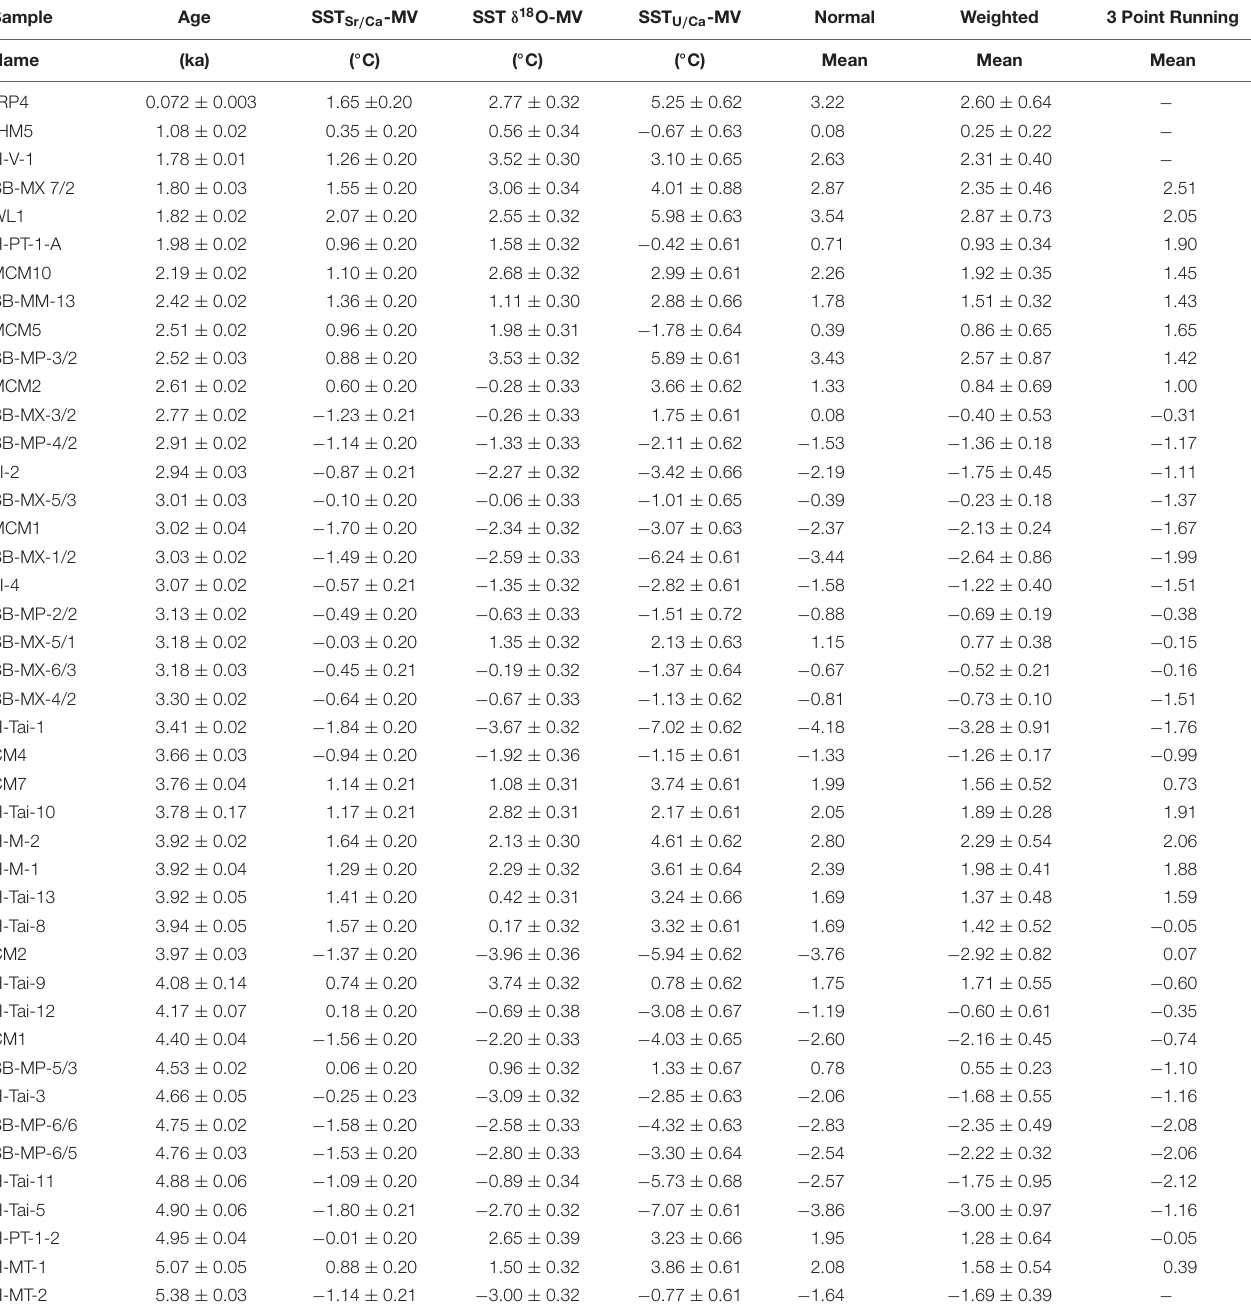
Data indicated by * are plotted as separate points due to a missing data gap in between. As a consequence, a three-point running mean is not available from these points (as there are only two data